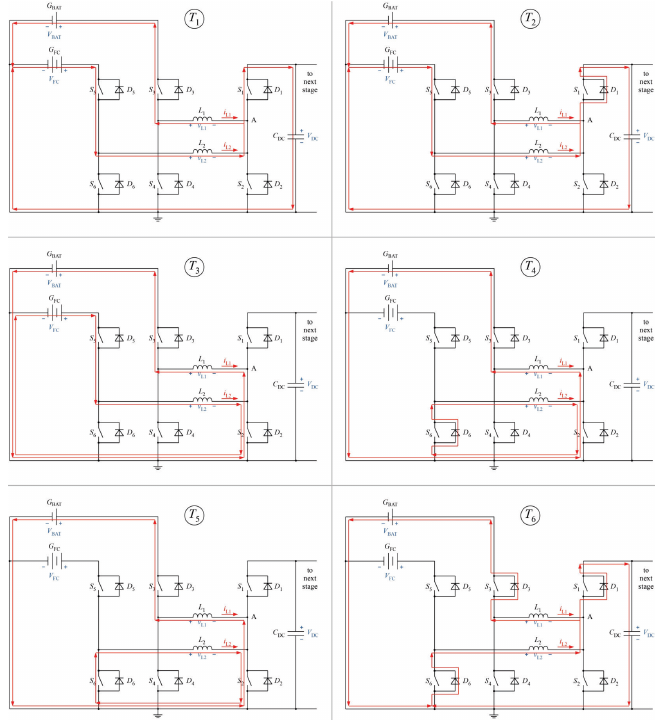
Figure 19. Current flow in FC2BDC- Buck-Boost mode for time intervals T 1 – T 6 . The active switching states and inductor currents and voltages inside the voltage- balancing stage during this mode are shown in Figure 20.